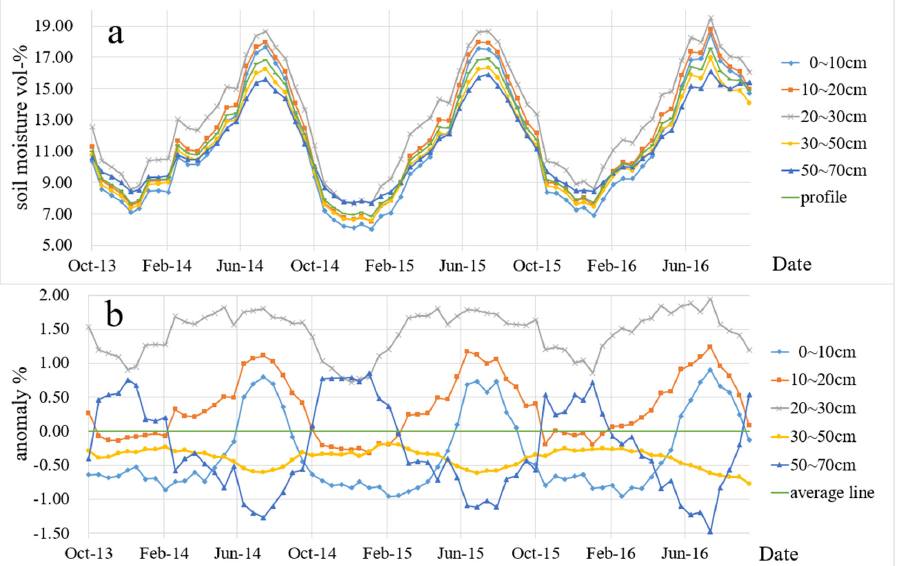
Figure 4. Temporal variability of soil moisture. ( a ) temporal variability of soil moisture in real value; ( b ) anomaly between each layer and the mean soil moisture.